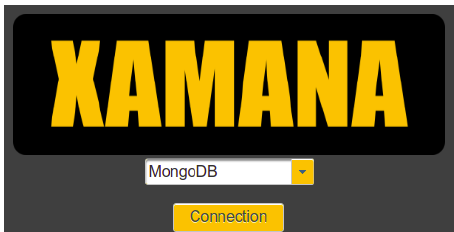
Figure 4. XAMANA web application home page.